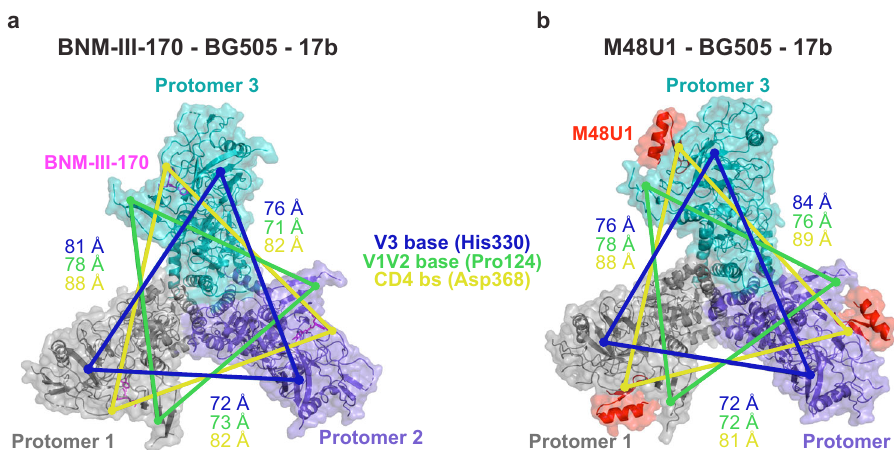
Fig. 3 BNM-III-170-bound and M48U1-bound Env inter-protomer dimensions match those of open CD4-bound Env. Structure colors: Protomer 1 = gray, protomer 2 = purple, protomer 3 = teal, BNM-III-170 = magenta, M48U1 = red. Top-down view of surface and cartoon rendering of a , BNM-III-170-bound and b , M48U1-bound Env trimer structures showing inter-protomer distance measurements between reference residues for the base of the V3 loop (His330 gp120 , blue), the base of the V1/V2 loop (Pro124 gp120 , green), and the CD4 binding site (CD4bs, Asp368 gp120 , yellow). 17b Fabs have been removed for clarity. Table 1 Interprotomer distances of envelope trimers.